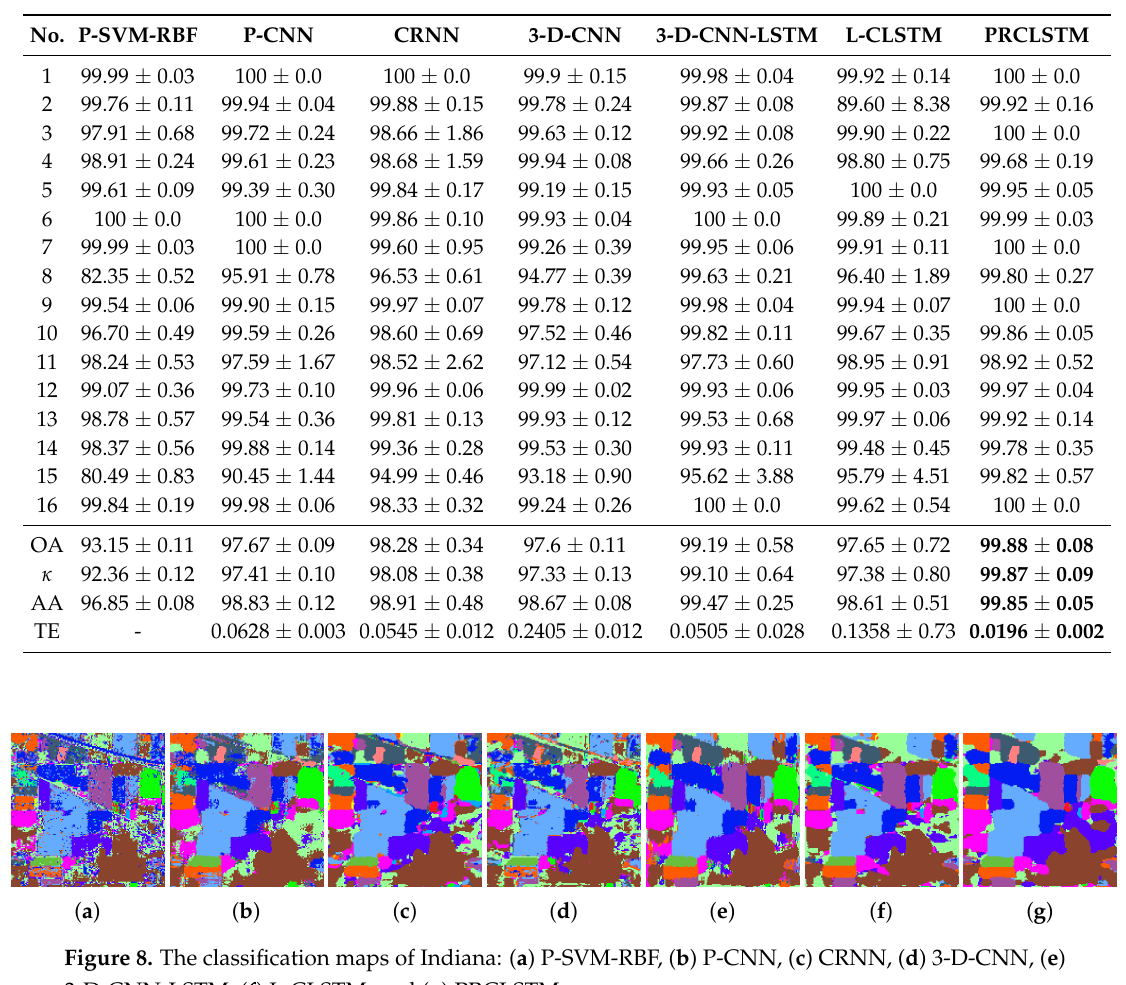
Table 7. A comparison between the classification results of the Salinas dataset with a fixed spatial size for the input cube and a sufficient number of training samples.